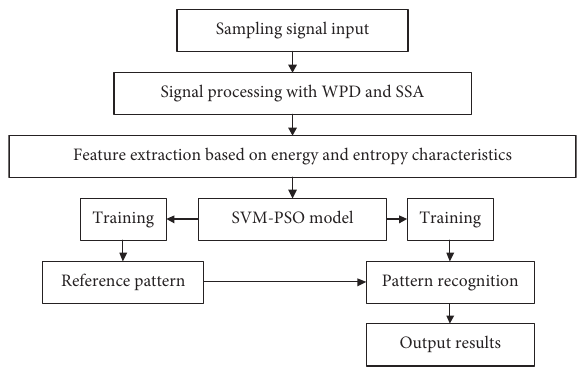
Figure 2: The scheme of the chatter detection